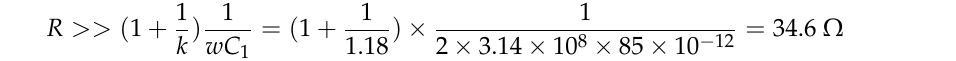
Table 1. Component values of TEV coupling module.